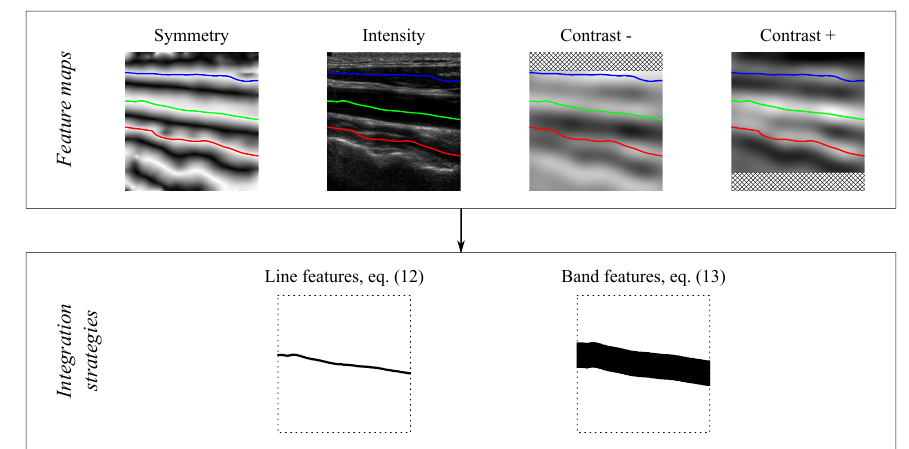
Figure 3. Feature computation. The symmetry Sym ( x ) , intensity I ( x ) and contrast C ± ( x ) feature maps are integrated along the candidate lumen paths using line and band